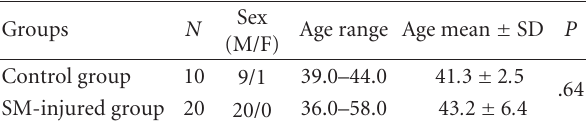
Table 1: Subject